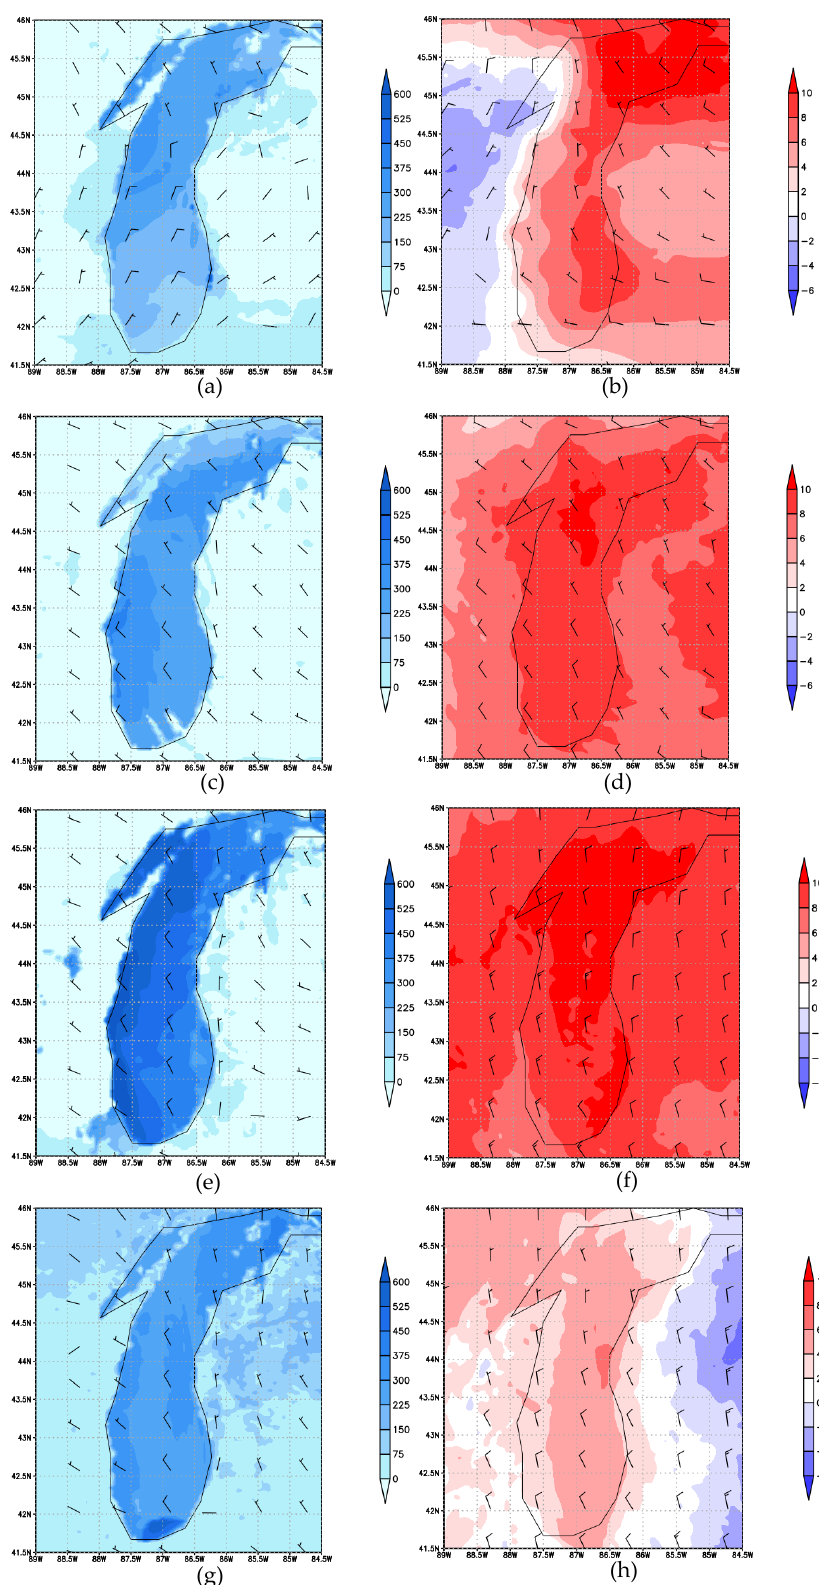
Figure 8. WRF-ARW simulated enthalpy flux (W m − 2 )/10-m surface winds (m s − 1 ) for Cluster 1 ( a ), Cluster 2 ( c ), Cluster 3 ( e ), and Cluster 4 ( g ); Surface-850 lapse rate ( ◦ C km − 1 )/925 mb winds (m s − 1 ) for Cluster 1 ( b ), Cluster 2 ( d ), Cluster 3 ( f ), and Cluster 4 ( h ). Simulations taken form peak LES activity. A half and full wind bard represents 5 and 10 m s − 1 ,